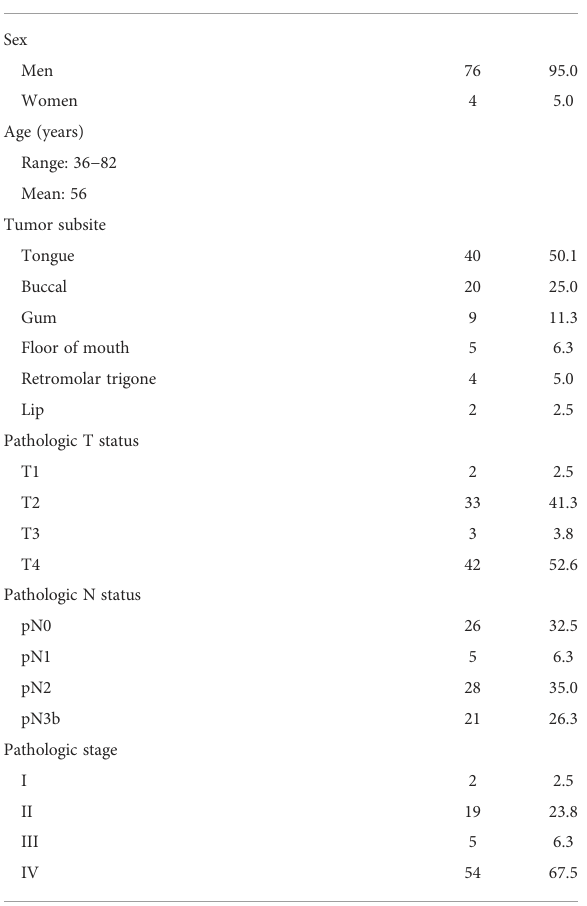
TABLE 1 General characteristics of patients with oral cavity squamous cell carcinoma included in the study. Characteristic (n, %; before PS